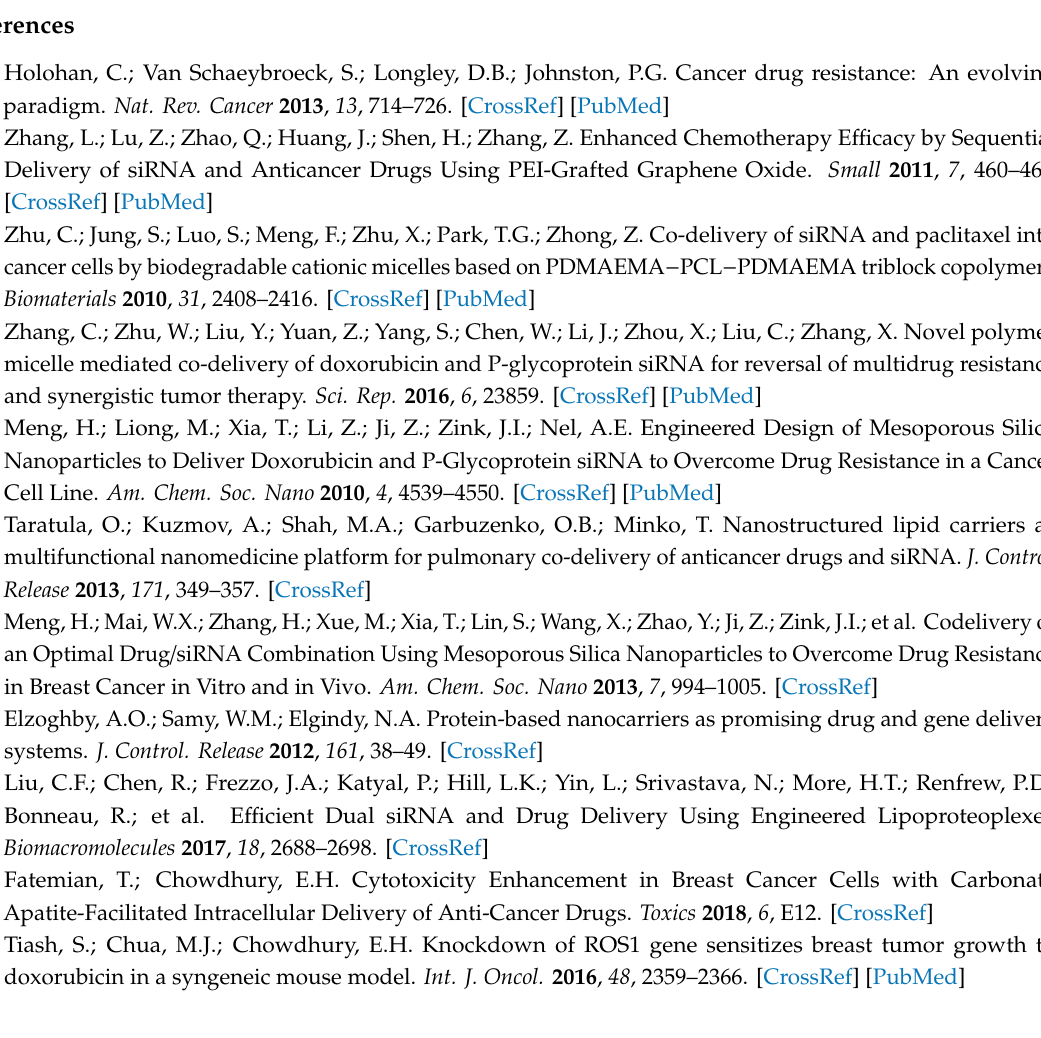
Figure S1. Cell viability assessment in 4T1 cells treated with siRNA loaded carbonate apatite. Figure S2. Carbonate apatite facilitated delivery of ERBB2 (A) and ROS1 (B) siRNA to MCF-7 cells. Figure S3. E ff ect of single pathway silencing on cytotoxicity of paclitaxel on 4T1 cells. Figure S4. E ff ect of single pathway silencing on cytotoxicity of docetaxel on 4T1 cells. Figure S5. E ff ect of single pathway silencing on cytotoxicity of mitomycin C on 4T1 cells. Figure S6. E ff ect of single pathway silencing on cytotoxicity of topotecan on 4T1 cells. Figure S7. E ff ects of single pathway silencing on paclitaxel cytotoxicity in MDA-MB-231. Figure S8. E ff ects of single pathway silencing on docetaxel cytotoxicity. Figure S9. E ff ects of silencing AKT and ERBB2 oncogenes on drugs cytotoxicity in 4T1. Figure S10. Cell viability assay on MDA-MB-231 cells treated with carbonate apatite complexed with paclitaxel and two